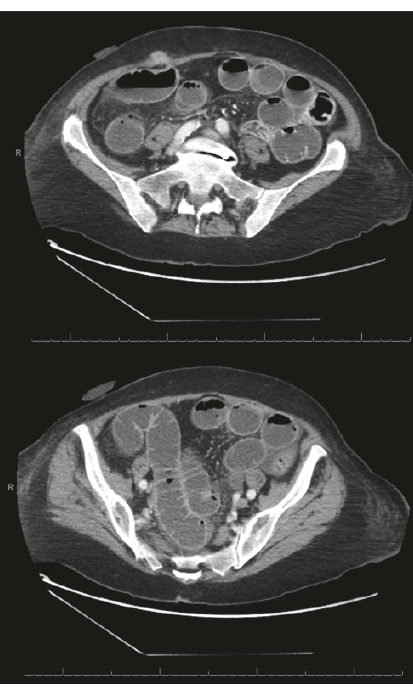
Figure 1: First CT scan abdomen and pelvis. Contrast-enhanced axial images showing port site hernia with diffuse small bowel dilation.